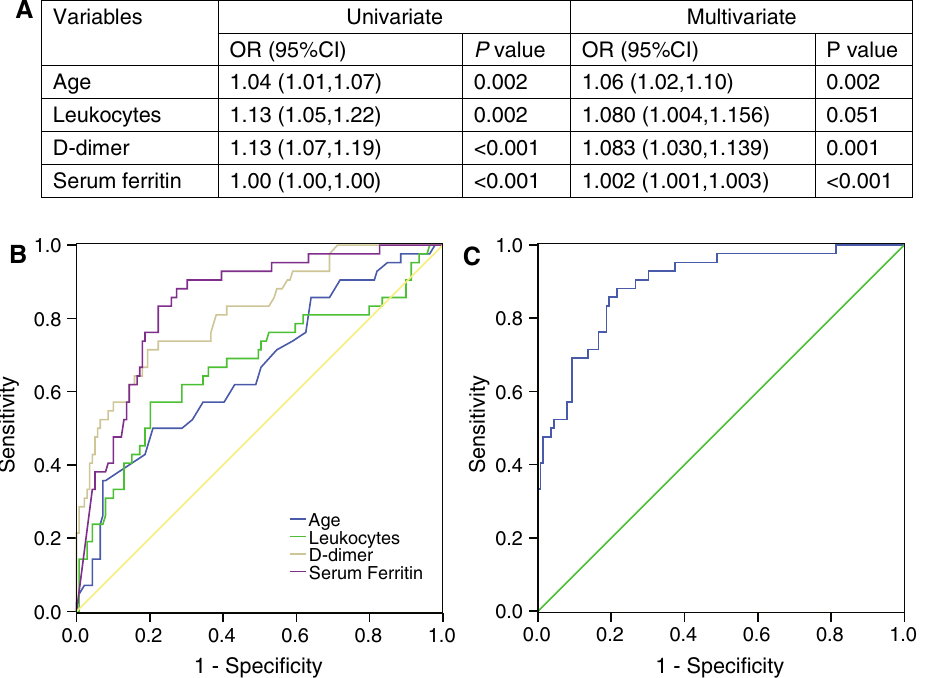
Figure 4. Receiver operating characteristic (ROC) analysis of the prediction of cardiac injury by multivariate regression model. ( A ) Univariate and multivariate logistic regression analysis of cardiac injury. ( B ) ROC curve of the prediction of cardiac injury by each variable. ( C ) ROC curve of the prediction of cardiac injury by the combined regression model of five variables. Area under the ROC curve (AUC) was 0.896, with a sensitivity of 83.30% and specificity of